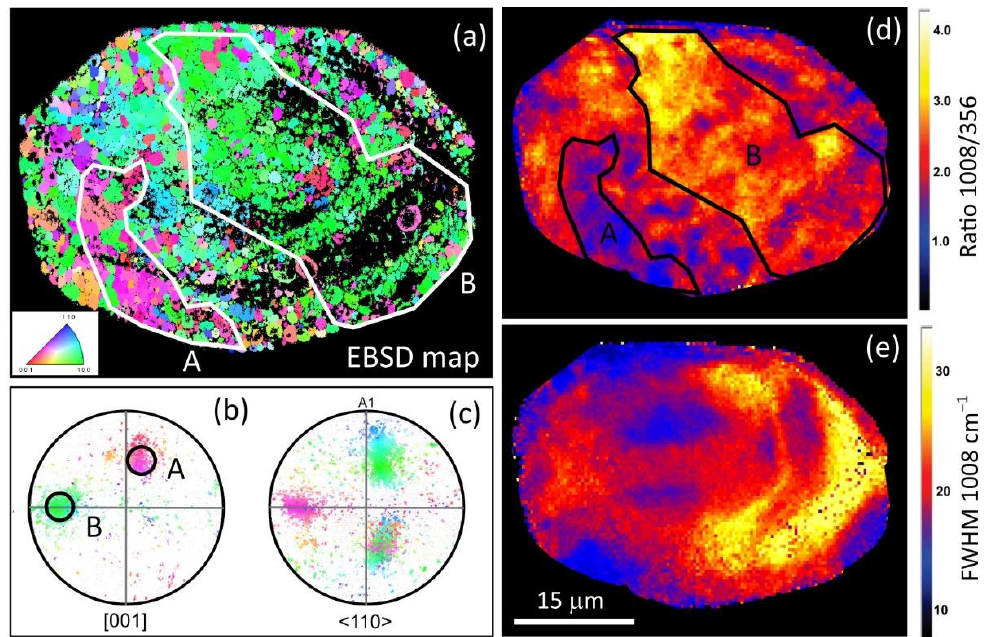
Figure 5. Correlation of EBSD and Raman spectroscopy data: ( a ) EBSD orientation inverse pole figure map, showing two major orientation groups: pink – orange (A), and green – blue (B); ( b , c ) equal angle lower hemisphere projection pole figures for zircon [001] and <110> directions, color coded as in ( a ); ( d ) Raman band intensity ratio B 1g /E g map shows patchy distribution (E g is a Raman band at 356 cm − 1 , B 1g is a band at 1008 cm − 1 ); ( e ) full width at half maximum (FWHM) of Raman band B 1g (1008 cm − 1 ) shows spatial variations in degree of radiation damage. Modified after [29]. Orientational groups of domains are marked as regions A and